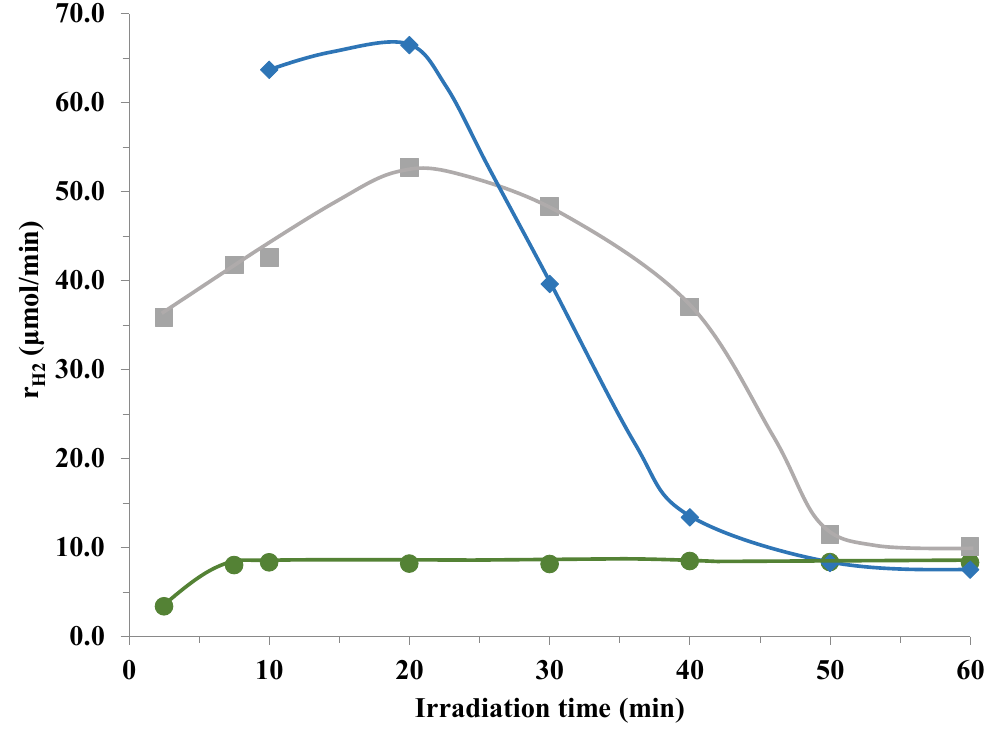
Figure 5. Differences in initial H 2 evolution rates according to the flow rate of the